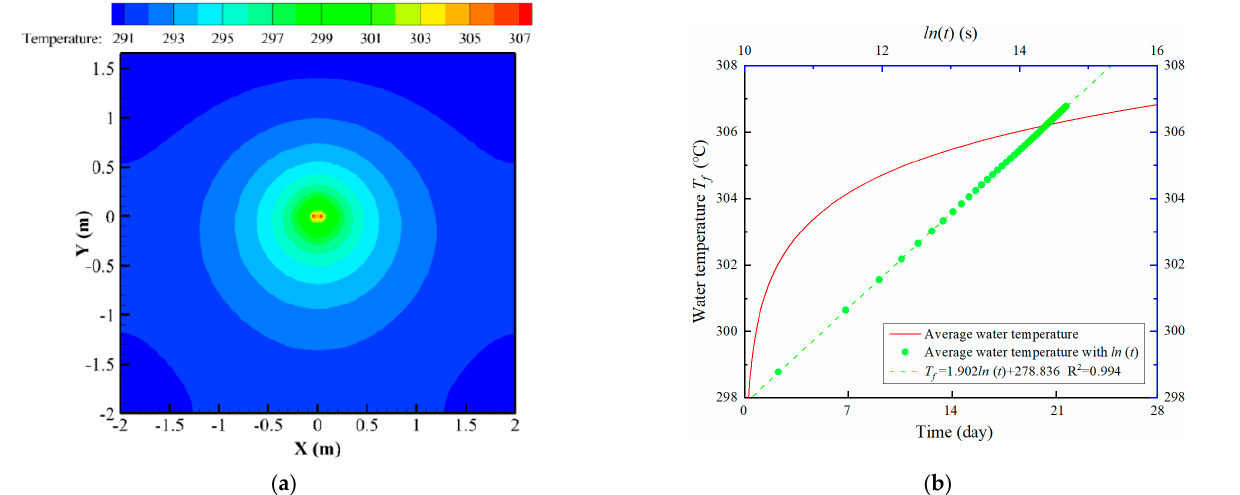
Figure 16. Thermal performance of CPB with a hydraulic conductivity of 1 × 10 − 7 m/s after 28 days of operation. ( a ) Temperature contour of cross ‐ section Z = 0; ( b ) variation of average water temperature in the HET over time.